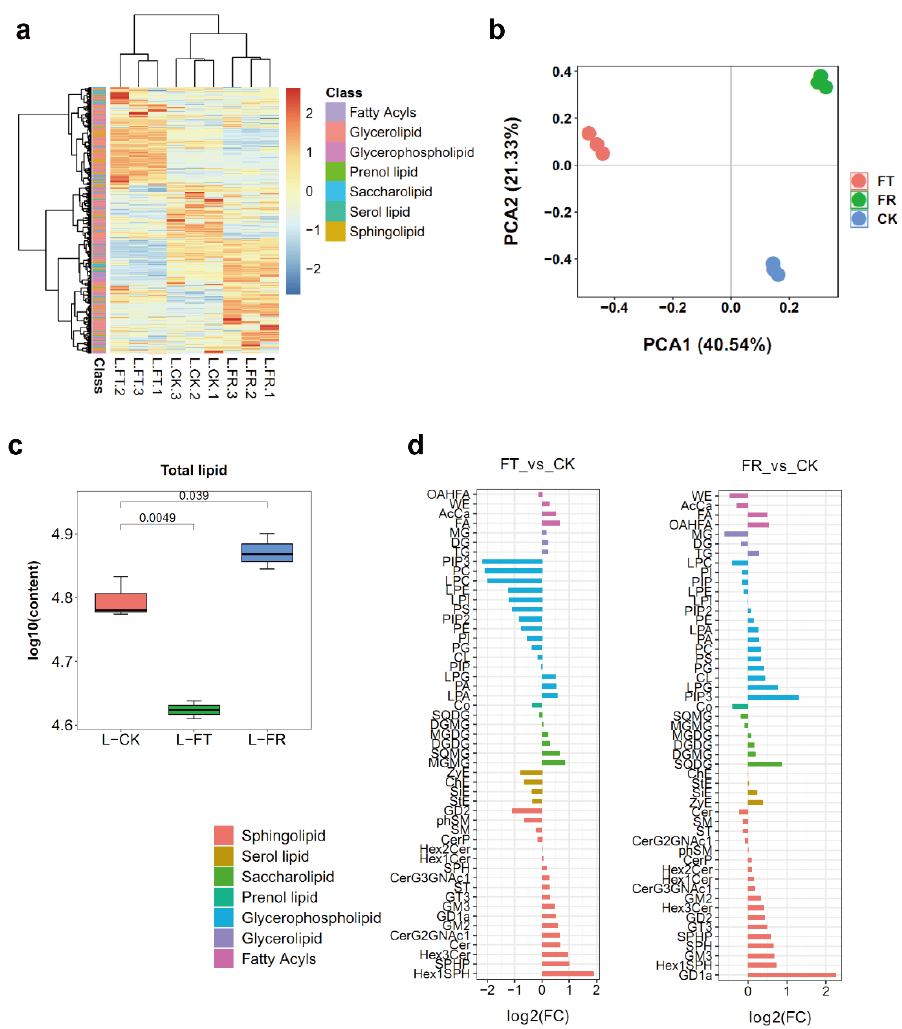
Figure 3. Overview of the lipidomes during freezing stress. ( a ) A heatmap of the abundance of lipid species in CK, FT, and FR. ( b ) PCA analysis of lipidomes in CK, FT, and FR. ( c ) The content of total lipid in CK, FT, and FR. Values are means ± S.D. ( n = 3); Student’s t -test. ( d ) Differentially accumulated lipids (DALs) of two comparisons. Lipid abbreviations are listed in Table S3.